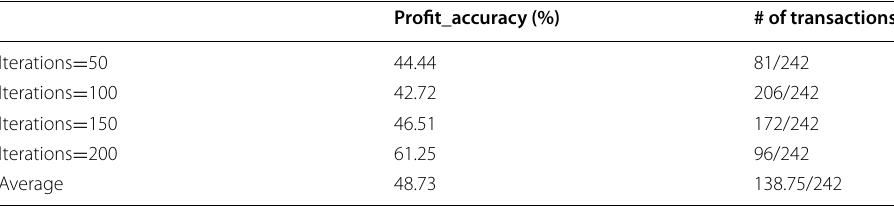
Profit_accuracy (%) # of transactions